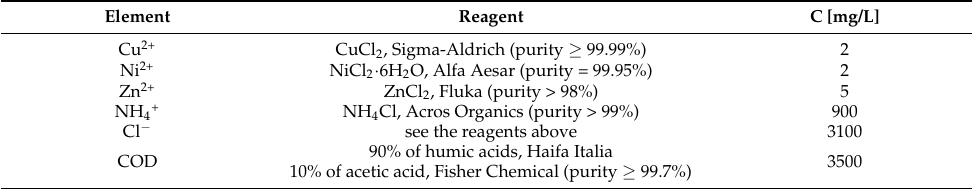
Table 1. Synthetic MLL composition used in column